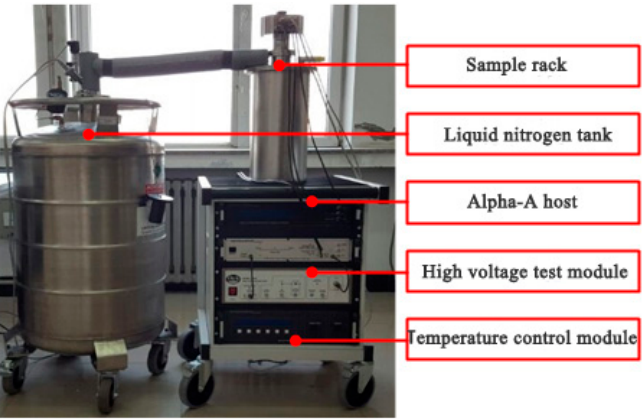
Figure 2. FDS measuring device.